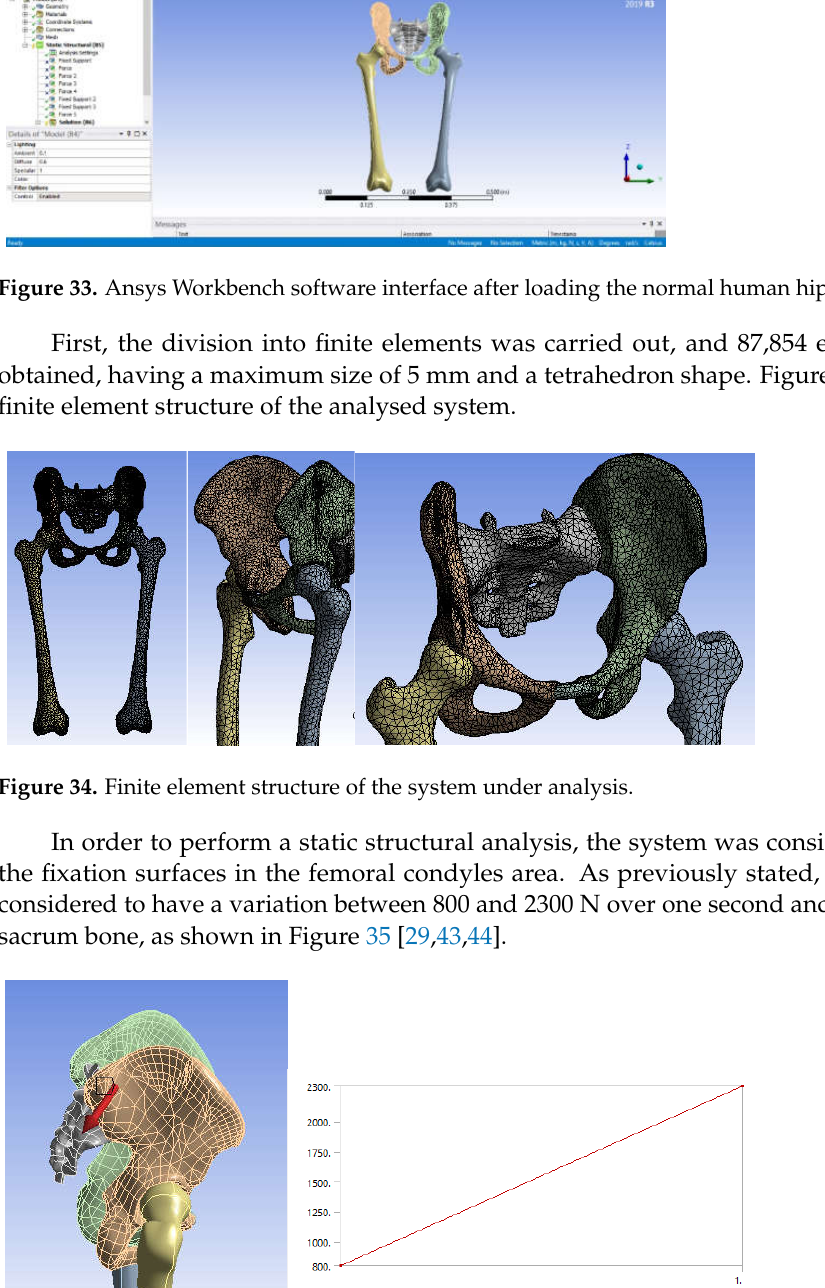
Figure 35. Position and variation of the force acting on the studied system.